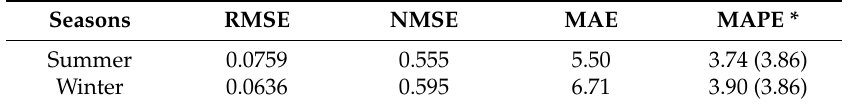
Table 9. The forecasting errors of the proposed